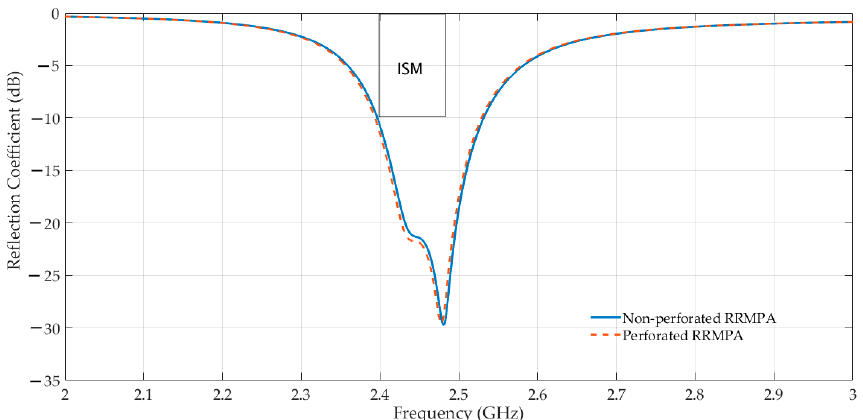
Figure 5. Front view ( a ) and back view ( b ) of the CST model of the perforated RRMPA.